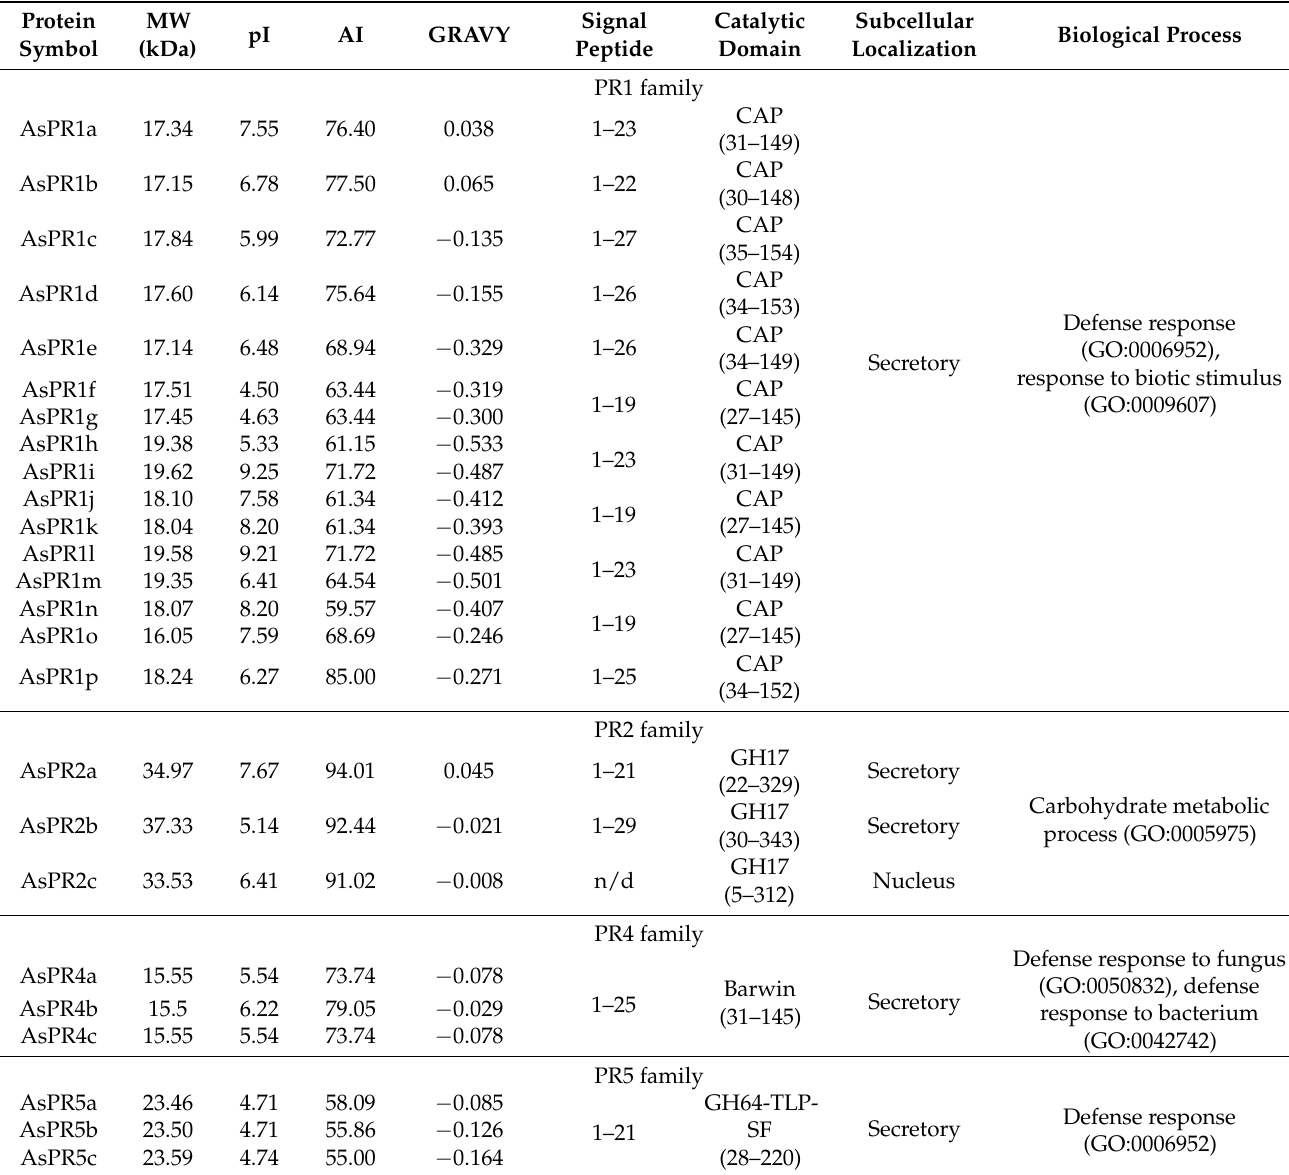
Table 2. Characteristics of PR1, PR2, PR4, and PR5 proteins predicted in A. sativum cv.